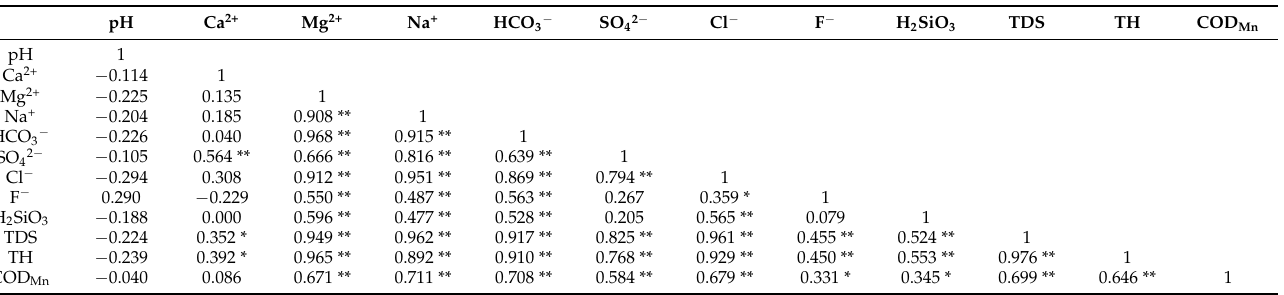
Table 4. Correlation matrices of hydrochemical indices (n = 38).